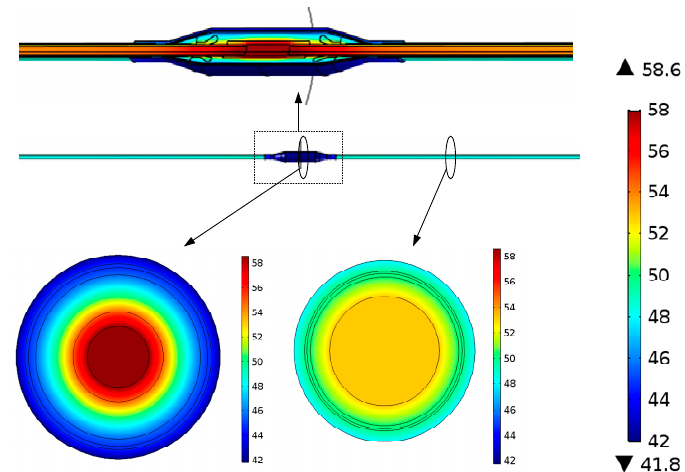
Figure 15. Temperature distribution of K = 5.